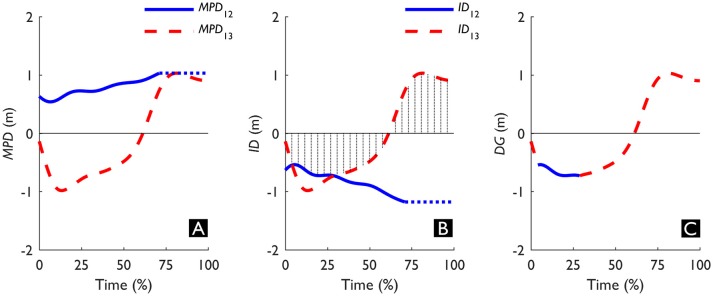
Exemplar data of one triadic trial showing the difference between (A) the Minimal Predicted Distance (MPD), (B) Interaction Distance (ID), and (C) Dynamic Gap (DG). The solid and dashed line refer to the interactions between Walker 1 (W1) & Walker 2 (W2) (i.e., interaction between W1 and W2, I12), and between W1 and W3 (i.e., interaction between W1 and W3, I13), respectively. The vertical lines in (B) indicate which interaction had the smallest absolute ID and upon which DG was based. The dotted horizontal line extending I12 in (A, B) denotes that the specific values were no longer updated as the time of minimal distance (tMD12) had already passed. See also Video 1 in the Supplementary Material for an animated display.